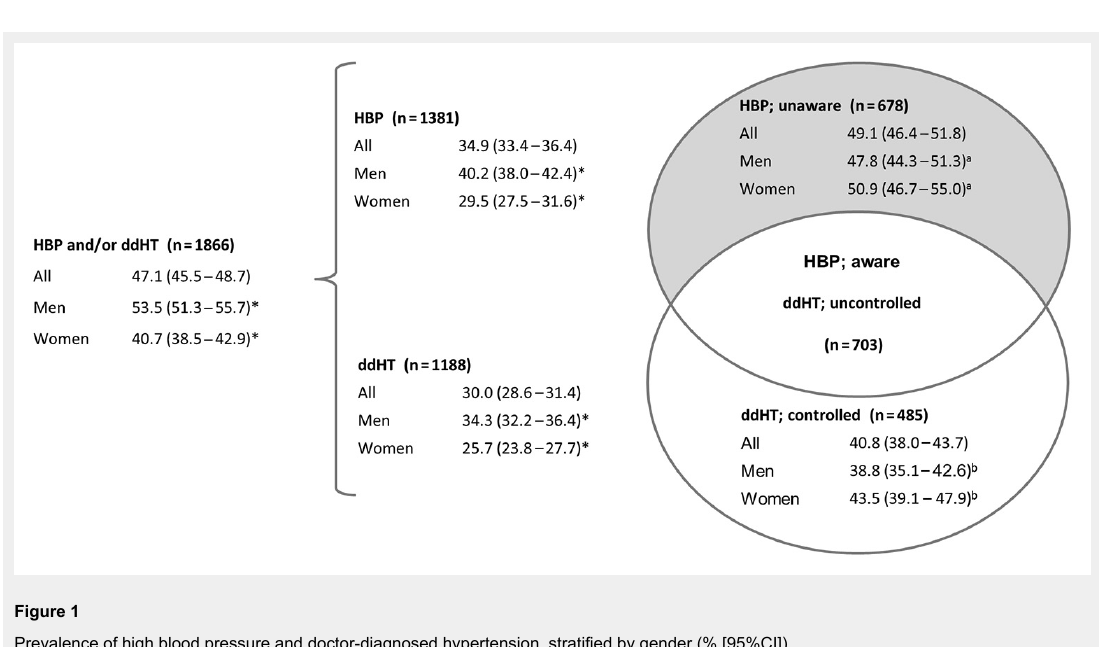
Figure 1 Prevalence of high blood pressure and doctor-diagnosed hypertension, stratified by gender (% [95%CI]) p-values for sex differences determined with chi-squared tests, * p <0.001, a p=0.262, b p = 0.104 CI = confidence interval; ddHT = doctor diagnosed hypertension; HBP = high blood